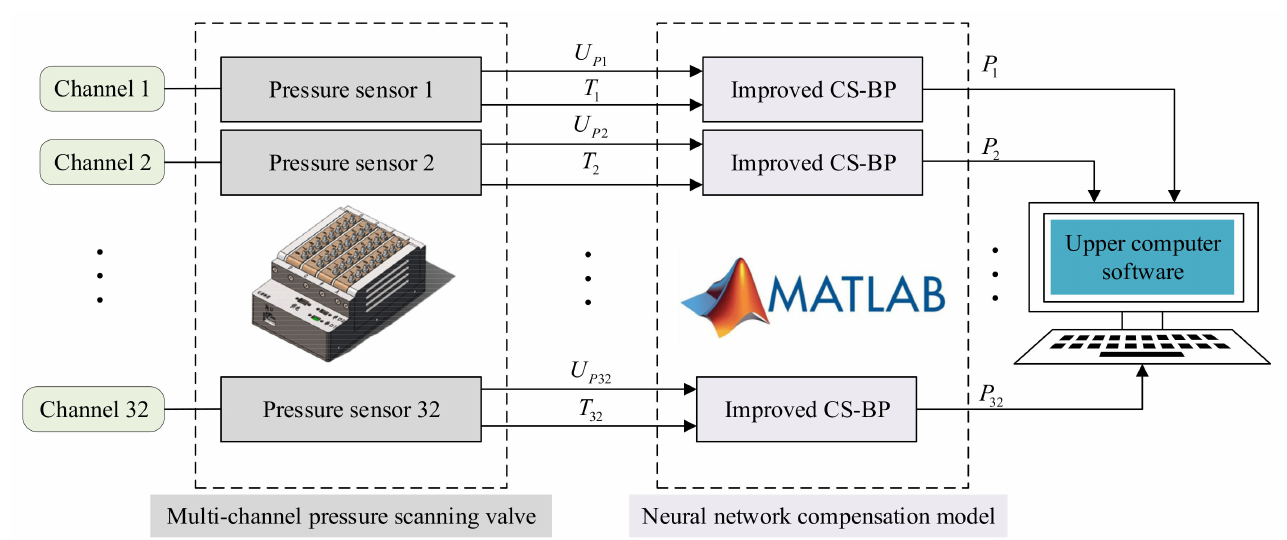
Figure 1. Temperature compensation schematic diagram of the multi-channel pressure scanner.